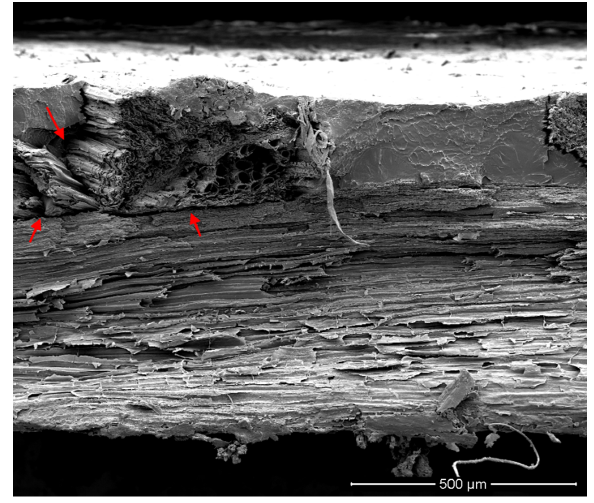
Figure 6. SEM micrographs of the fracture surface of the RANDOM composite. Red arrows indicate matrix ‐ poor areas.